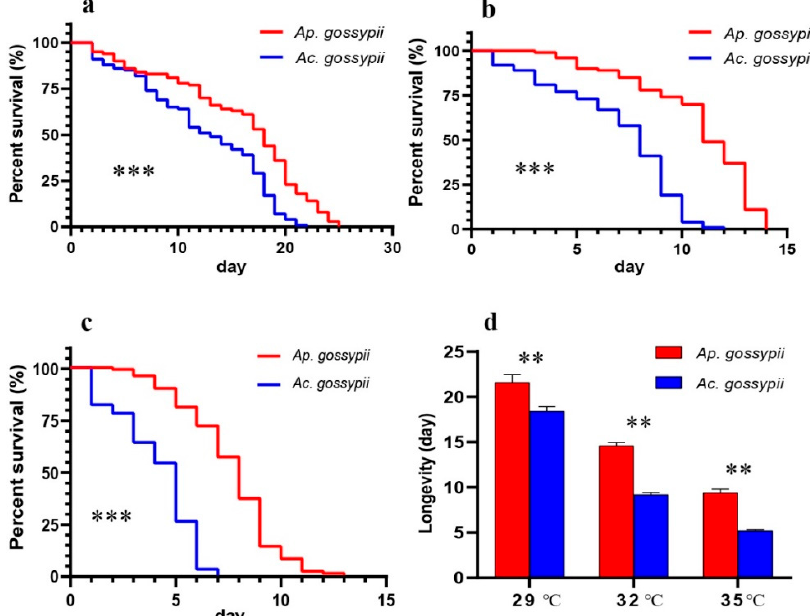
Figure 2. Survival curves of adults of Aphis gossypii and Acyrthosiphon gossypii at three temperatures: ( a ) 29 °C; ( b ) 32 °C; ( c ) 35 °C; and ( d ) longevity of adults of both species. Survival statistics were calculated using the Kaplan–Meier survival curve and compared using the log-rank test (individual = 100). The results from two independent groups of longevity were assessed using Student’s t-test. The error bars indicate standard error (SE). **, p < 0.01; ***, p < 0.001.